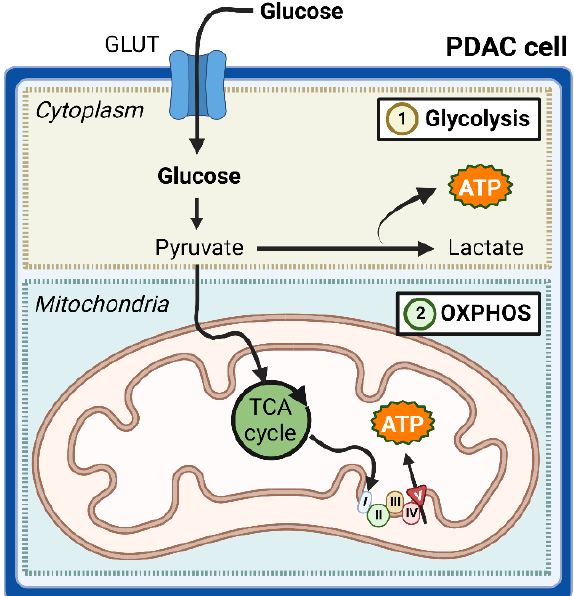
Figure 8. Unlike cancer cells in general, pancreatic ductal adenocarcinoma (PDAC) cells can respire via glycolysis and oxidative phosphorylation (OXPHOS). The OXPHOS system of the mitochondrial inner membrane is composed of five enzymes (complexes I-V), which are shown as I, II, III, IV and V in the figure. Abbreviations: GLUT—glucose transporter, ATP—adenosine triphosphate, TCA—tricarboxylic acid. Figure created with BioRender.com.